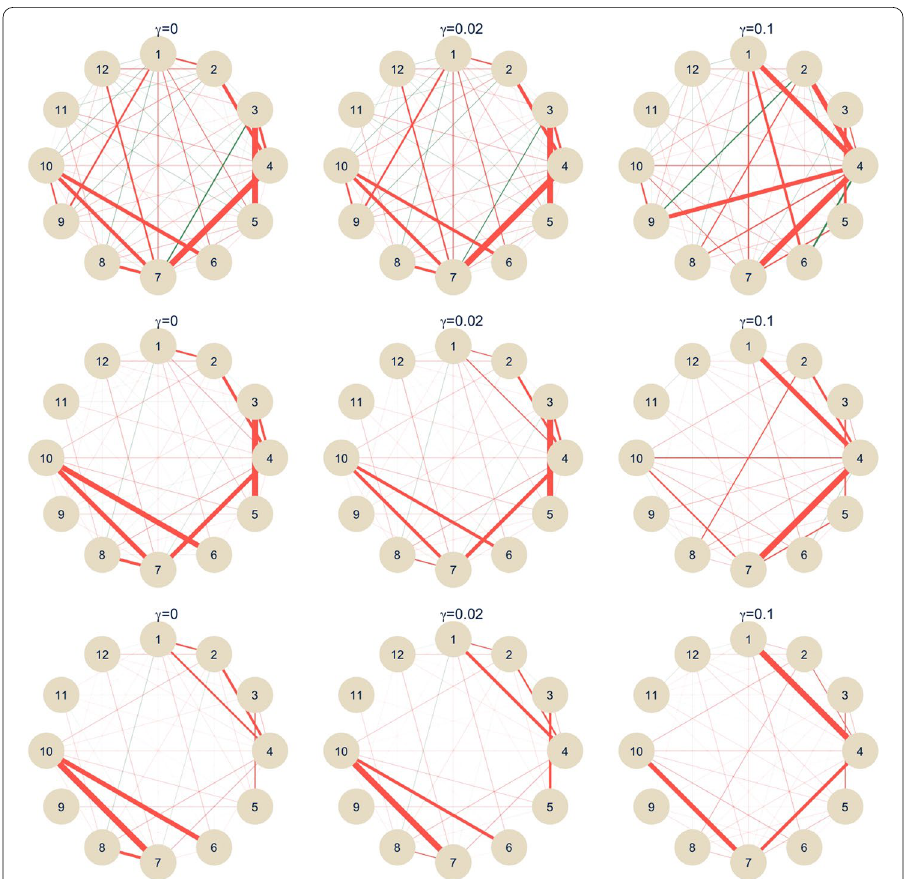
Fig. 9 Conditional correlations around April 30 2021, using the bandwidth parameter h = 20 (first row), h = 50 (second row) and h = 100 (third row). The parameter γ refers to the robustness parameter: γ = 0 means no robust